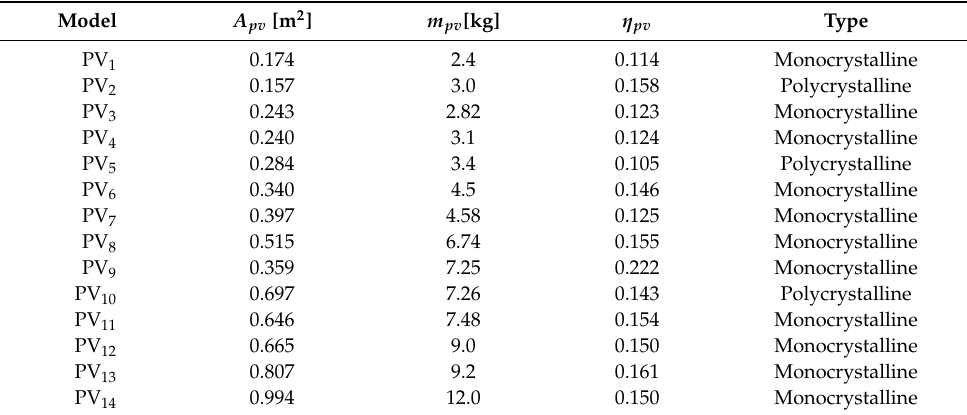
Table 10. Parameters of commercial photovoltaic solar panels.